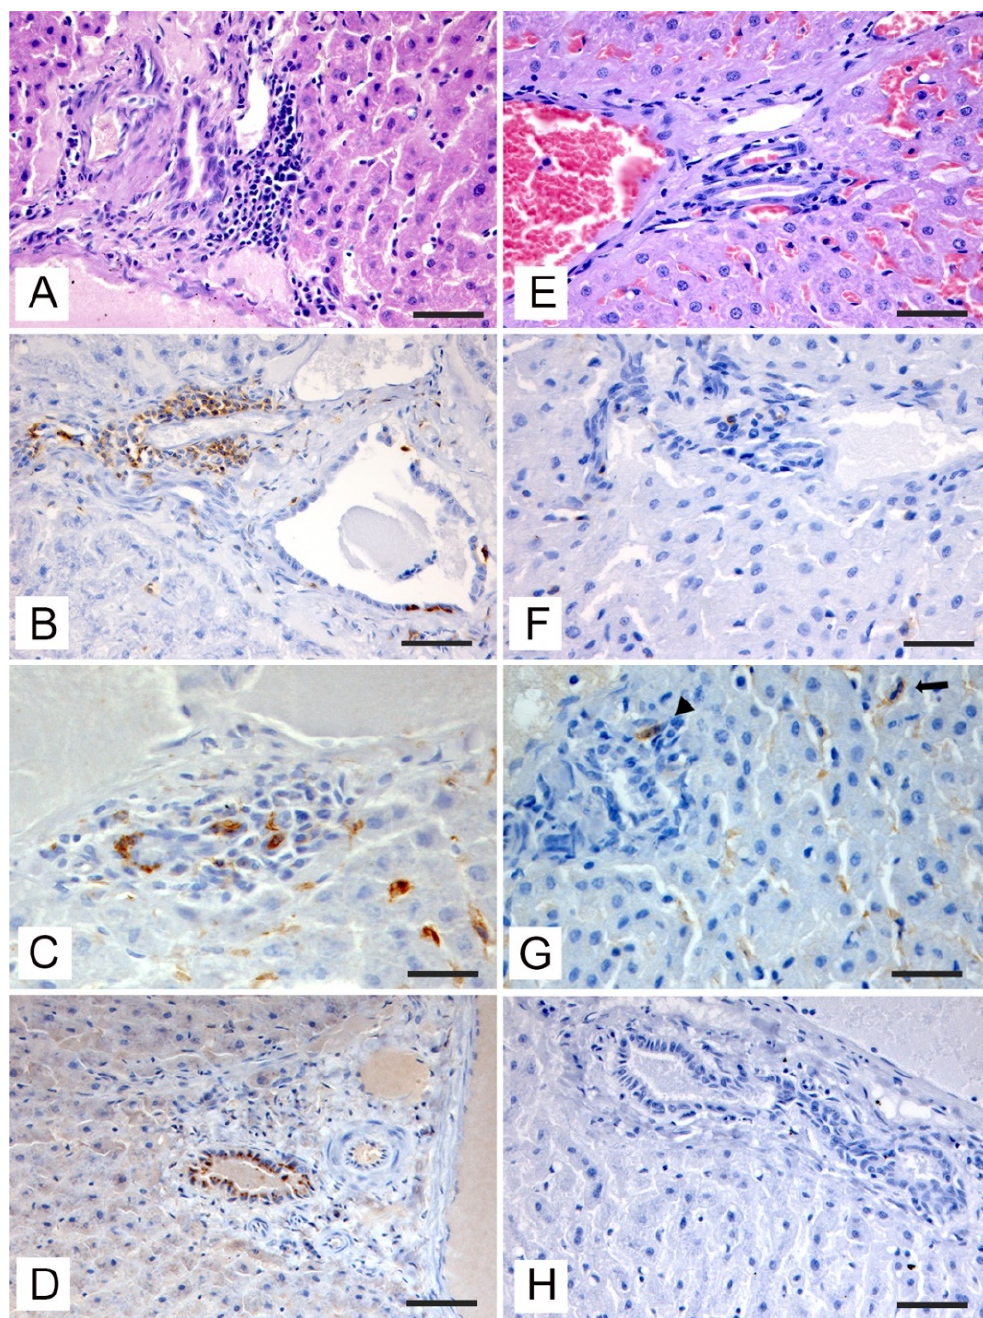
Figure 3. Liver tissue sections from PCR investigated samples. ( A ) HEV-positive roe deer; periductal lymphocytic infiltration in the portal space ( H , E , bar = 50 μ m). ( B ) HEV-positive roe deer; CD3+ periductal inflammatory infiltrate with small clusters of cells in contact with the basal dominium of positive cholangiocytes (IHC, bar = 100 μ m). ( C ) HEV-positive roe deer; cluster of macrophages infiltrating the portal space stained with anti-Iba-1 antibody (IHC, bar = 50 μ m). ( D ) HEV-positive roe deer; immunohistochemical staining with granular cytoplasmic pattern in cholangiocytes incubated with anti-HEV antibody (IHC, bar = 100 μ m). ( E ) Roe deer HEV-negative; absence of periductal inflammatory infiltrate ( H , E , bar = 50 μ m). ( F ) HEV-negative roe deer; little amount of CD3+ periductal lymphocytes (IHC, bar = 50 μ m). ( G ) HEV-negative roe deer; resident Kupffer cells labeled with anti-Iba-1 antibody (arrow) and a single macrophage cell, also labeled (arrowhead) (IHC, bar = 50 μ m). ( H ) HEV-negative roe deer; cholangiocytes with no staining after incubation with anti-HEV antibody (IHC, bar = 100 μ m).